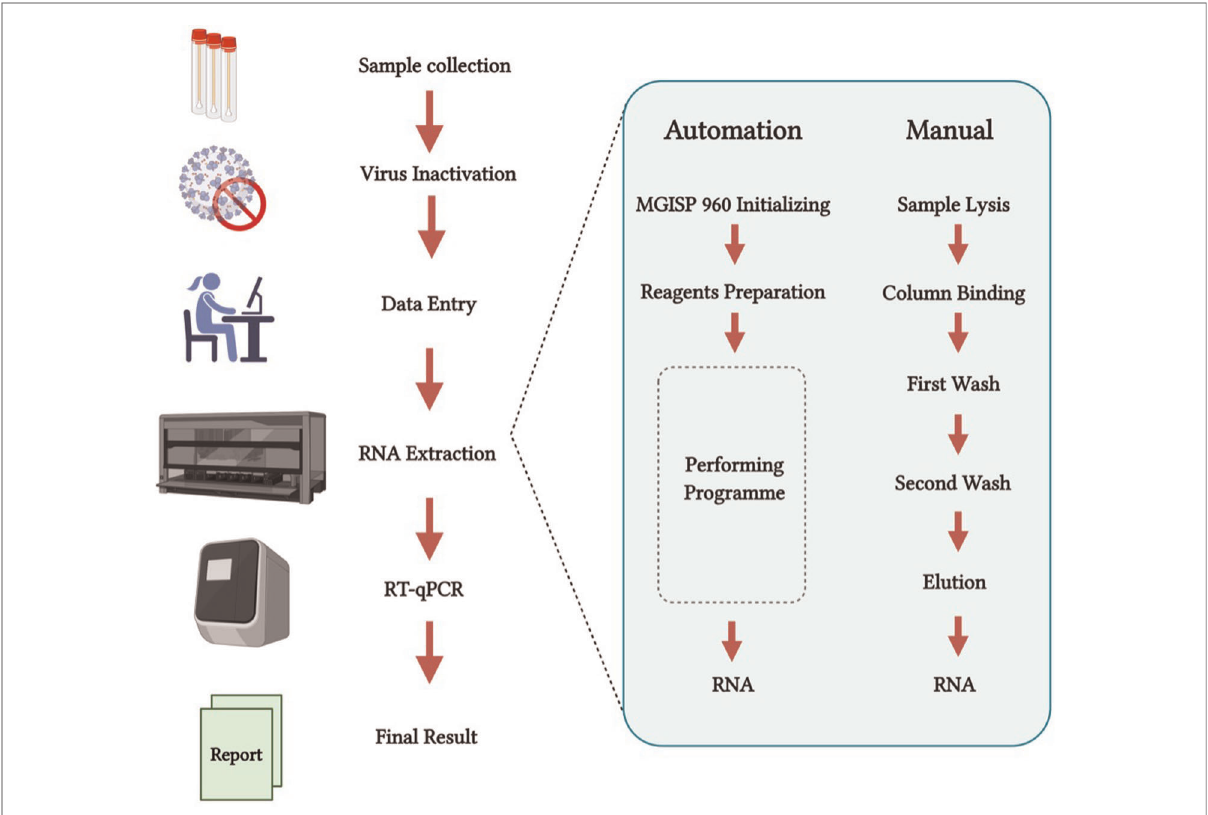
FIGURE 2 (created with BioRender.com). RT-qPCR test work fl ow comparing both manual and automated nucleic-acid extraction in Huo-Yan Lab. Automation platforms increase testing capacity whilst simultaneously decreasing processing time. Modi fi ed from Liu et al.